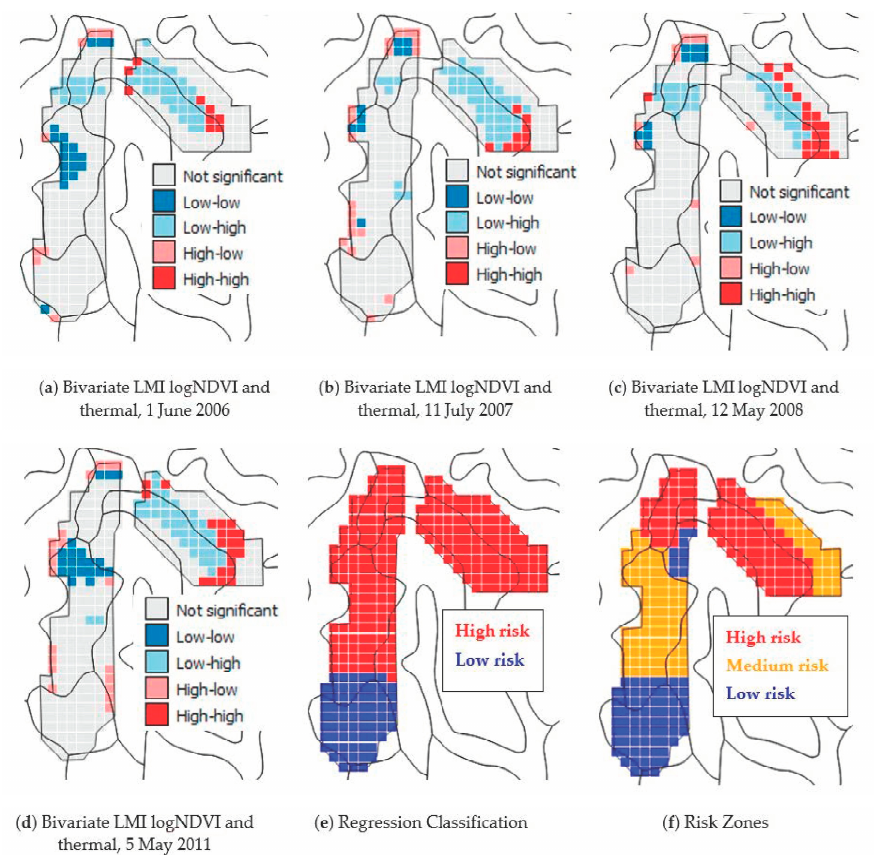
Figure 7. Pixel maps (30 m) of bivariate local Moran’s I (LMI) of NDVI and Thermal IR ( a – d ) and zones based on two ( e ) or three ( f ) classes. Black lines show soil series risk zones based on two ( e ) or three ( f ) classes. Black lines show soil series boundaries.